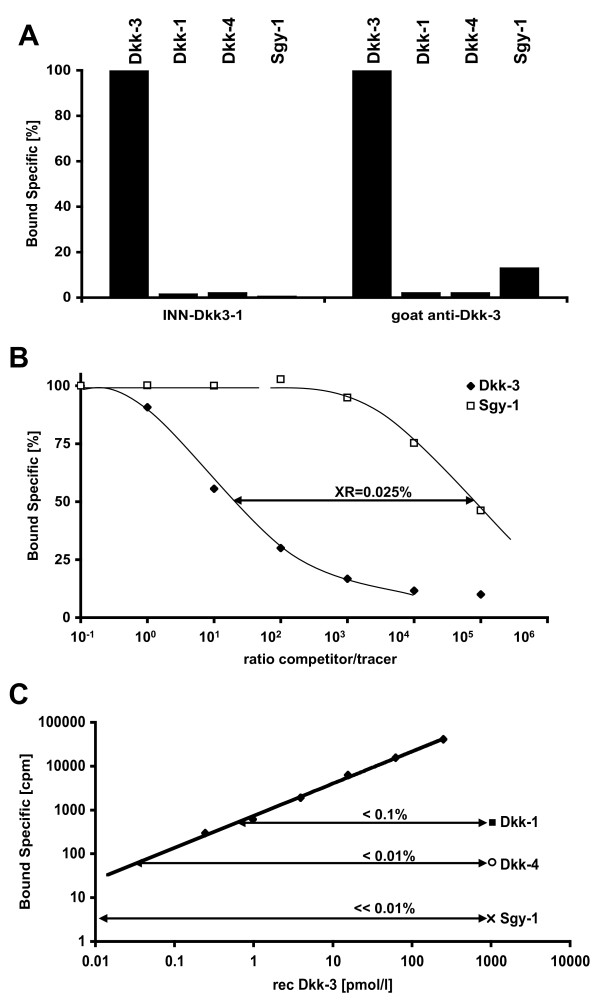
Establishment of the Dkk-3 assay. mAb INN-Dkk3-1 and goat polyclonal antibody (R&D Systems) showed no significant cross-reactivities with homologous proteins Dkk-1 and Dkk-4. The polyclonal antibody (5 μg/mL) showed weak reactivity for the homologous protein Sgy-1 in a direct binding RIA (A). In a competitive RIA the goat polyclonal antibody showed a cross-reactivity (XR) of 0.025% for Sgy-1 (B). A standard curve from 0.25 pmol/L - 250 pmol/L Dkk-3 in comparison to the homologous proteins at a concentration of 1000 pmol/L revealed cross-reactivities in the sandwich assay of < 0.01% (C). The established sandwich assay had a recovery of 92% and sensitivity of 1 pmol/L. The intra- and inter-assay variances (%CV) at a protein concentration of 40 pmol/L were 11% and 13%, respectively.